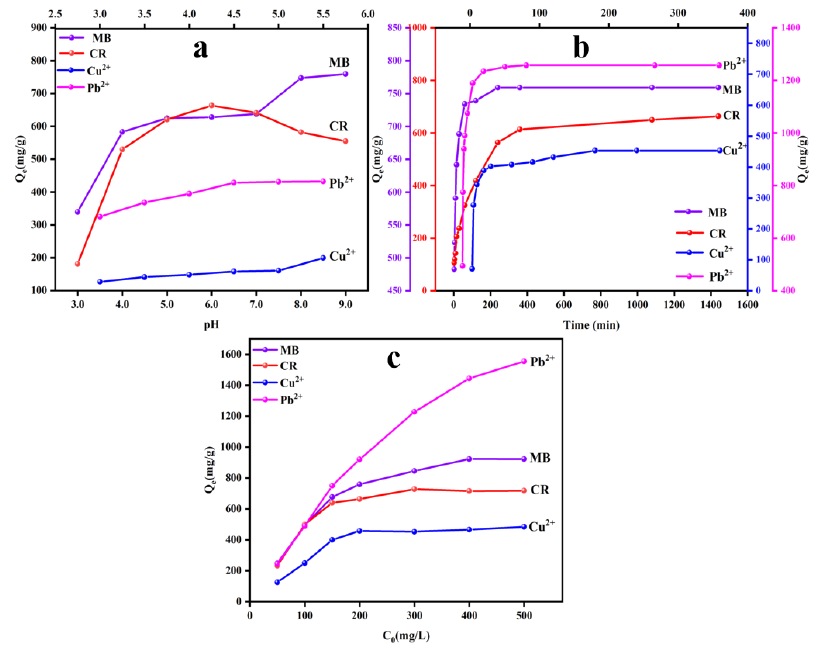
Figure 2. The influence factors of adsorption performances of UBC for MB, CR, Cu 2+ , and Pb 2+ : pH ( a ); adsorption time ( b ) and solution concentration ( c ). ( a ); adsorption time ( b ) and solution concentration ( c